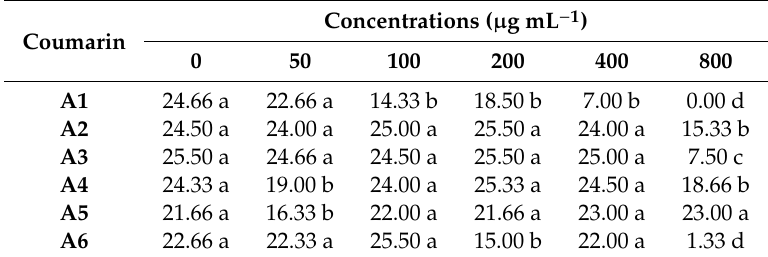
Table 2. Averages obtained for the number of normal seedlings of Lactuca sativa exposed to the six eugenol-derived